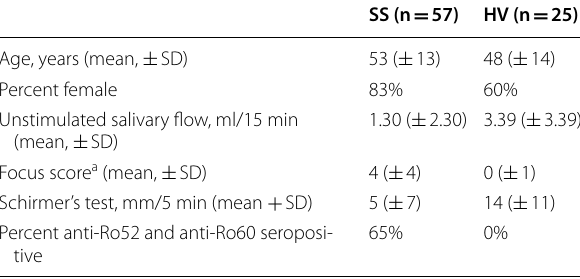
Table 1 Characteristics of 57 patients with primary SS and 25 healthy volunteers